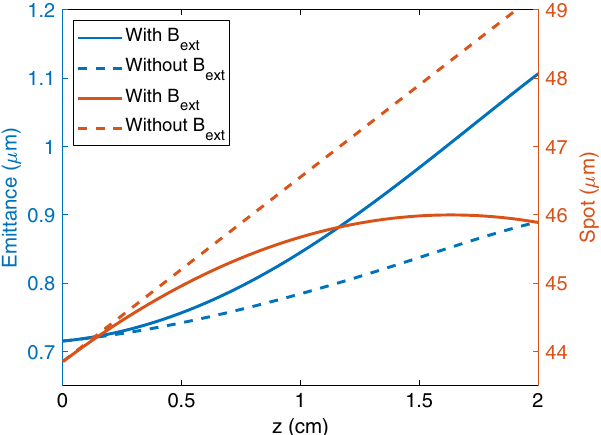
FIG. 9. Witness normalized emittance (blue lines) and spot size (red lines) along a 2-cm-long APL by including (solid lines) or not (dashed lines) the magnetic field produced by the discharge current.